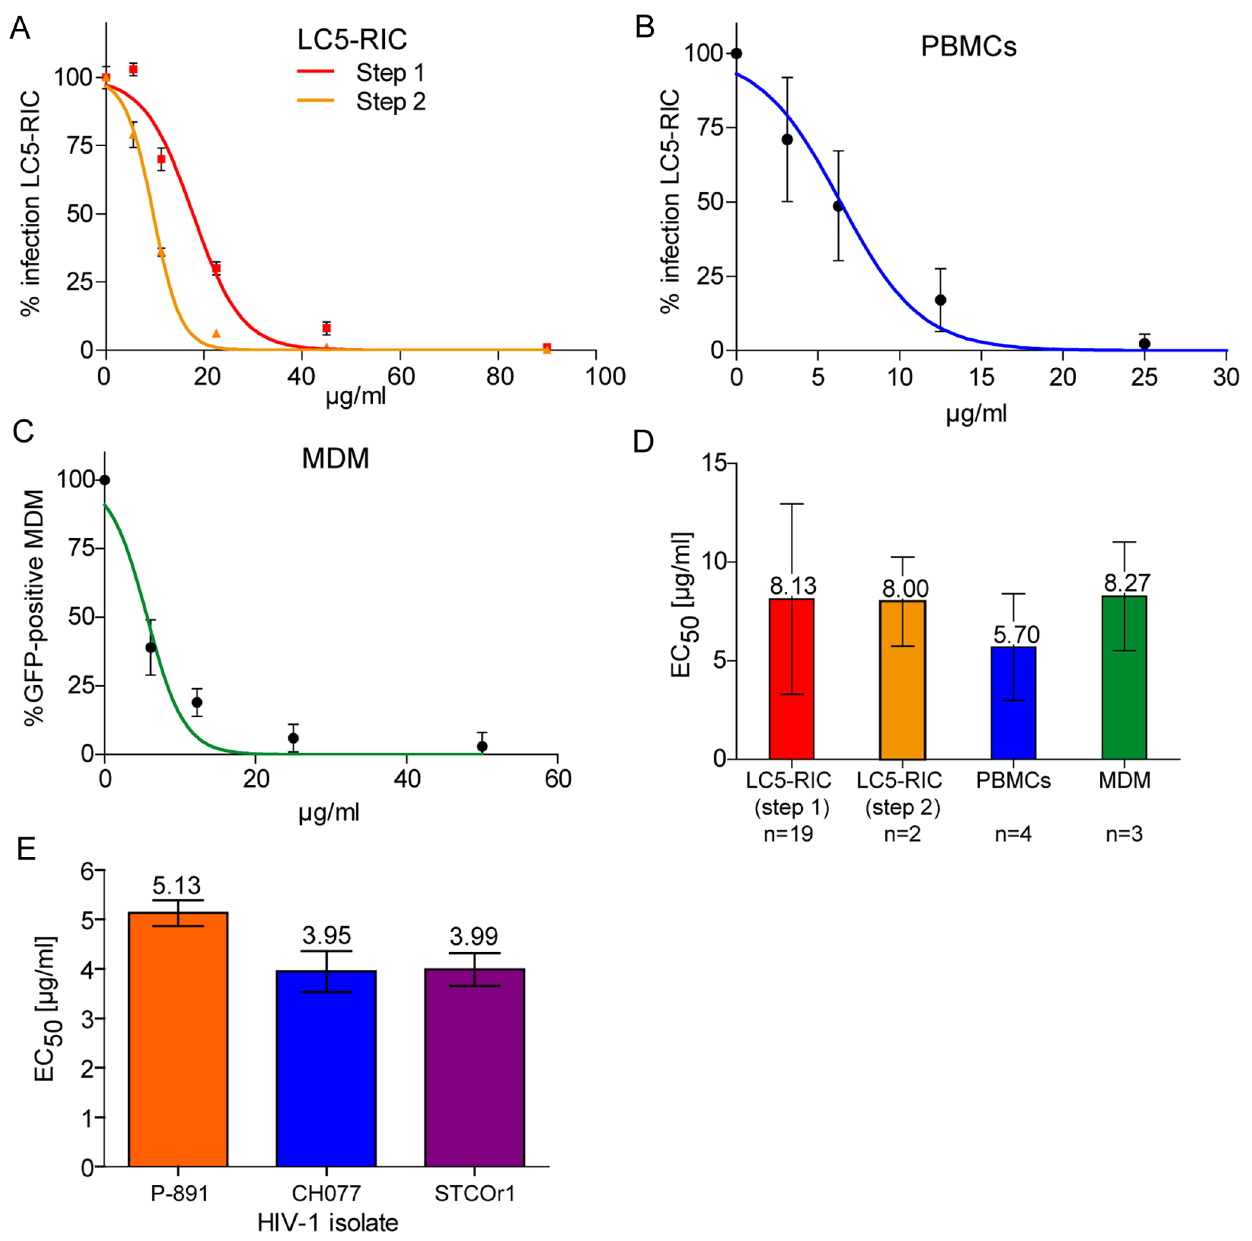
Figure 1. Evaluation of anti-HIV-1 activity of Pelargoniumsidoides (PS) aqueous root extract with various HIV-1 target cells and HIV-1 isolates. Panels A-C show representative results for dose-dependent inhibition of HIV-1 infection of LC5-RIC indicator cells, human peripheral blood mononuclear cells (PBMC) and human monocyte-derived macrophages (MDM) by PS extract. Data for infection of PS-treated cultures are expressed in percentage of values measured for untreated cultures (=100% infection). The graph in D shows the EC 50 values calculated from multiple independent infection experiments (n=number of independent infection experiments) for each cell type. Panel E shows HIV-1 inhibitory activity (EC 50 ) of PS extract against clinical HIV-1 isolates. A , HIV-1 reporter cells (LC5-RIC) were exposed to HIV-1 LAI and serial dilutions of PS extract and infection assayed by measuring reporter gene expression (step 1) and production of infectious virus (step 2). Mean values and standard deviation of the mean are indicated for each extract dilution. B , IL-2 stimulated PBMCs were exposed to HIV-1 LAI and different concentrations of PS extract and levels of infectious virus in culture supernatants of PBMCs assayed with LC5-RIC cells. Results are shown for 4 independent infection experiments using PBMCs that were pooled from 4 different donors, with each extract concentration assayed in triplicate in each experiment. C , MDMs were exposed to the HIV-1 reporter virus R5 HIV-1NL4-3 IRES-eGFP that coexpresses Nef and EGFP from a bicistronic mRNA via an IRES element. Three days later, proportions (%) of GFP positive cells were determined by flow cytometry. Data were normalized to values for untreated cells. Results are shown for three independent infection experiments with MDMs from different donors. D , The graph shows EC 50 values (effective concentration for half- maximal inhibition) for each cell type, calculated from the compiled results of multiple independent infection experiments. n=number of independent infection experiments with triplicate analysis of each extract concentration. Mean values and standard deviations of the mean are indicated for each cell type. E , HIV-1 reporter cells (LC5-RIC-R5) were exposed to the indicated clinical HIV-1 isolates and serial dilutions of PS extract in triplicate wells and reporter gene expression was measured 5 days post infection. Mean values and standard deviations of the mean are indicated for each HIV-1 isolate.